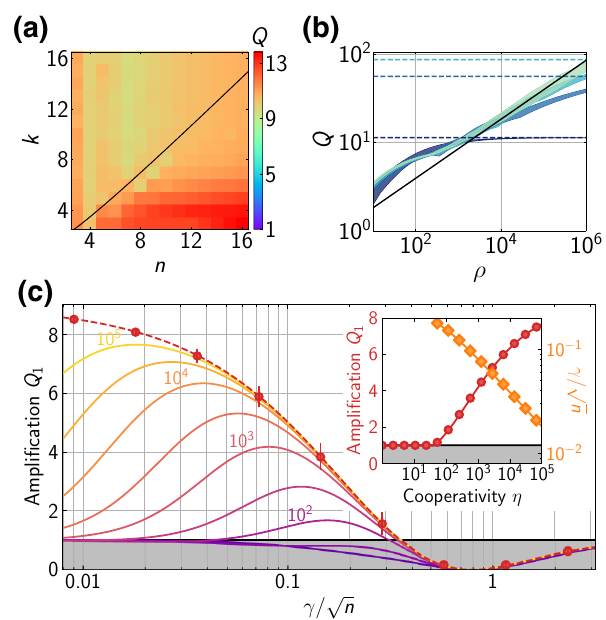
FIG. 5. Effects of dissipation. (a) Median speedup [ Q ] ver- 0.5 sus ( n , k ) in the presence of decay with interaction-to-decay ratio ρ = 10 3 . Solid black line denotes k = k c . (b) Median speedup [ Q ] versus ρ for n = k = ( 4, 6, 8, 10 ) denoted by dark blue 0.5 to light green shaded lines. The shading denotes the interquar- tile range. Black solid line denotes scaling Q ∼ ρ 1 / 3 . Dashed lines show maximum achievable Q for each system size n . (c) Amplification versus step width γ for T = 1. Solid curves show average amplification in large- N limit for finite cavity coopera- tivity η = 10 1 , 3 × 10 1 , 10 2 , 3 × 10 2 , . . . , 10 5 (purple to yellow) and for unitary evolution (red dashed). Dark red circles show simulated amplification at n = k = 12 with no dissipation; error bars denote standard deviation. Inset shows optimal amplifica- tion (red circles) and step width (orange diamonds) versus η for n = k = 12, matching the prediction for large N (solid